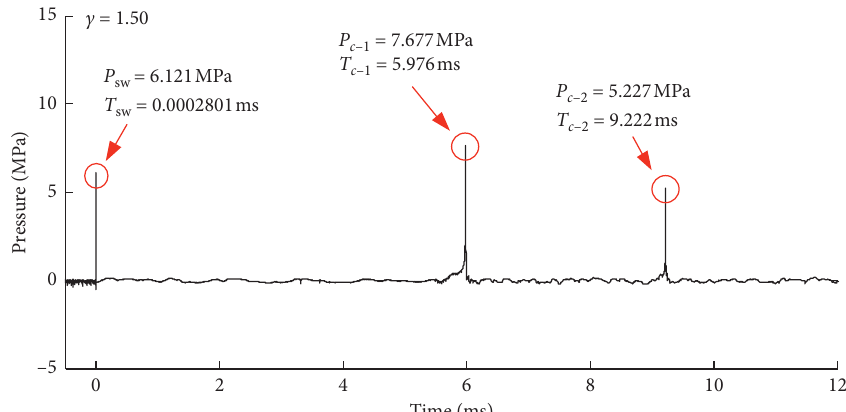
Figure 35: Pressure-time diagram of the first and second cycles of the spark-generated bubble load for c �